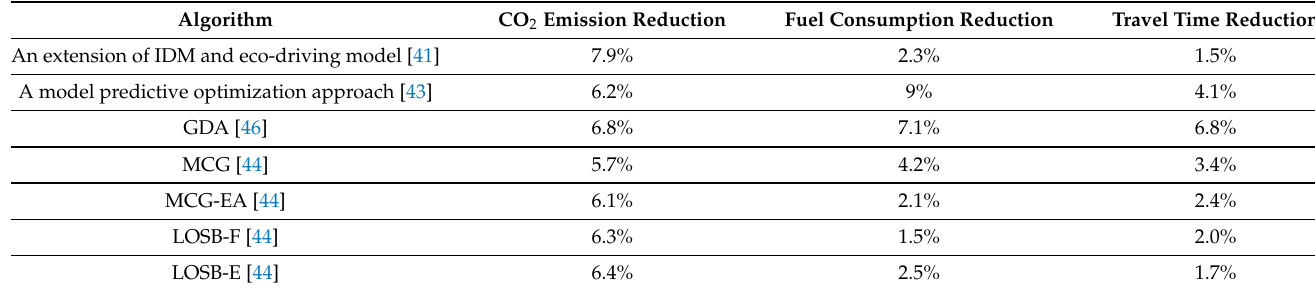
Table 5. Performance comparison of